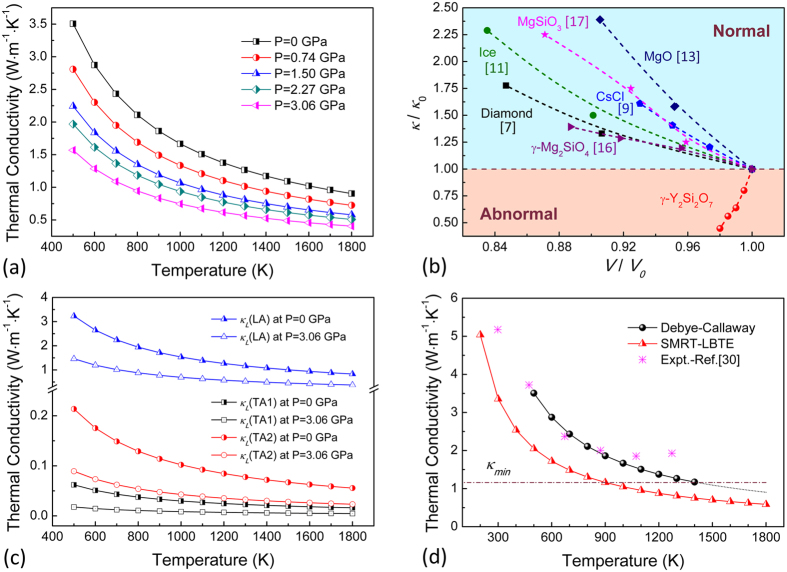
(a) Temperature dependence of lattice thermal conductivity (κL) for Y2Si2O7 as a function of hydrostatic pressure up to P = 3.06 GPa. (b) Comparison of normal and abnormal κL(P) dependency in some representative solids. Referenced data are collected at 300 K for diamond7 and Ice11, 296 K for CsCl9, 2000 K for MgO13, 1000 K for γ-Mg2SiO416 and MgSiO317, and 600 K for Y2Si2O7. κ0 and V0 denote lattice thermal conductivity and equilibrium volume, respectively, at P = 0 GPa for each referenced compound. (c) Partial contributions () of TA and LA phonons to the total κL of Y2Si2O7 at P = 0 and 3.06 GPa (d) Comparison of lattice thermal conductivity of Y2Si2O7 (P = 0 GPa) from modified Debye-Callaway model, solution of linearized phonon Boltzmann equation combined with single-mode relaxation-time approximation (SMRT-LBTE method), and experimental data30. Minimum thermal conductivity (κmin)52 at equilibrium geometry is presented in dash-dot line as a guide for the eye.